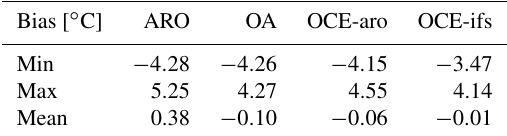
Table 3. Minimum, maximum and mean SST bias ( ◦ C) values against L3 SST observations at the end of the simulated period (19 October 2018, 00:00UTC, i.e. + 168h) for each experiment (note that ARO SST is constant since 12 October 2018, 00:00UTC). This table is complementary to Fig.